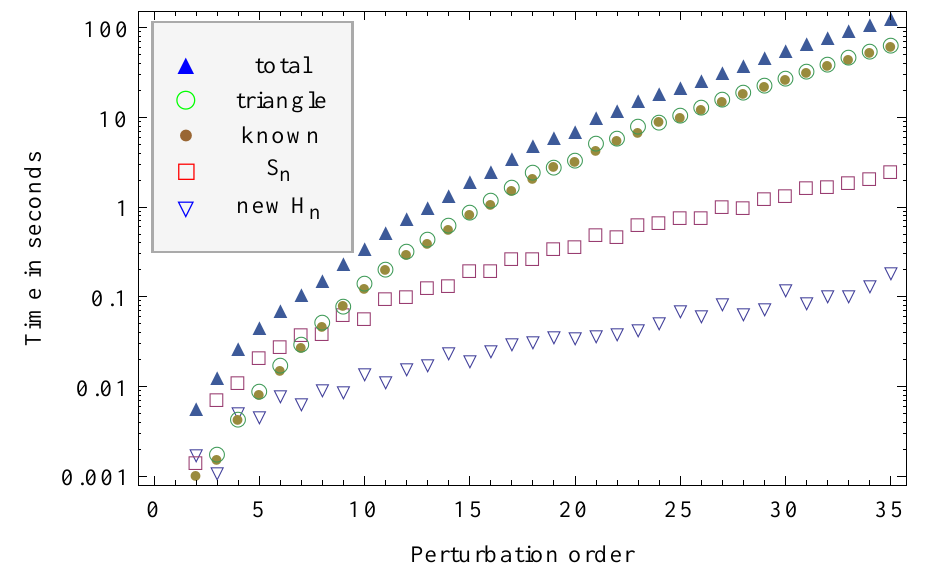
Fig. 1 Absolute times (in logarithmic scale) spent in the computation of each order of the Lie transforms